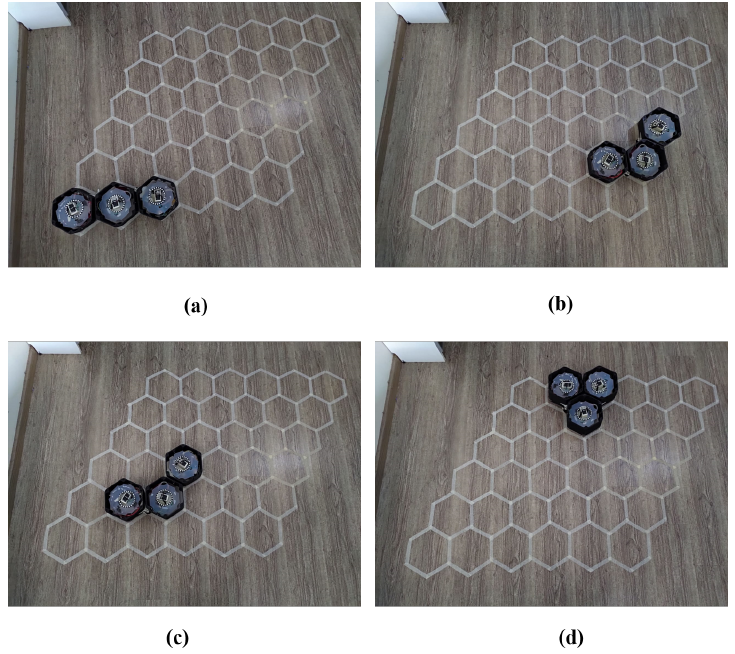
Figure 17. Real tested workspace with 12 tileset as in the simulated workspace in Figure 14c: ( a ) robot at waypoint 1; ( b ) robot at waypoint 5; ( c ) robot at waypoint 7; and ( d ) robot at waypoint